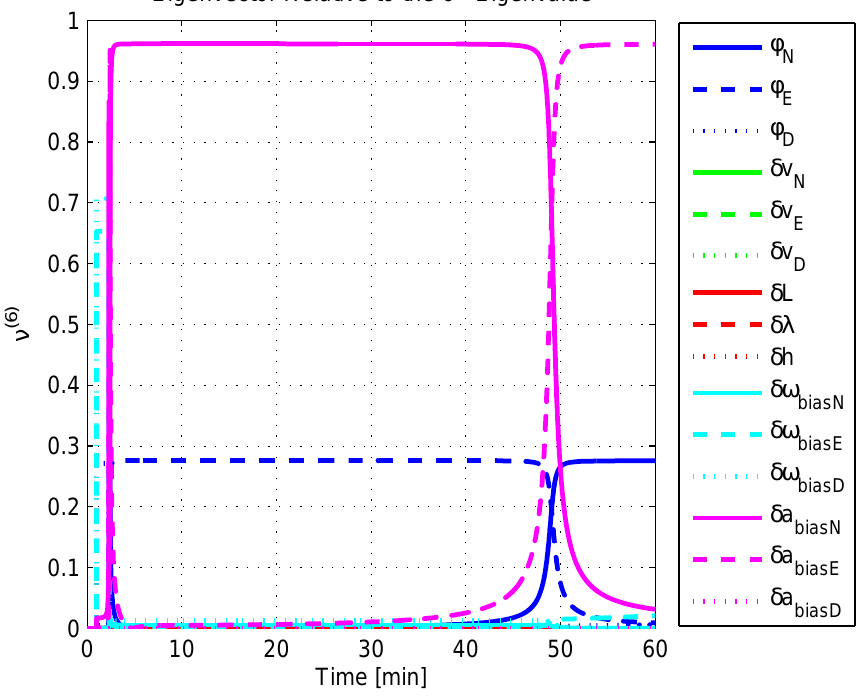
Figure 21. Eigenvector relative to the sixth eigenvalue in the experimental